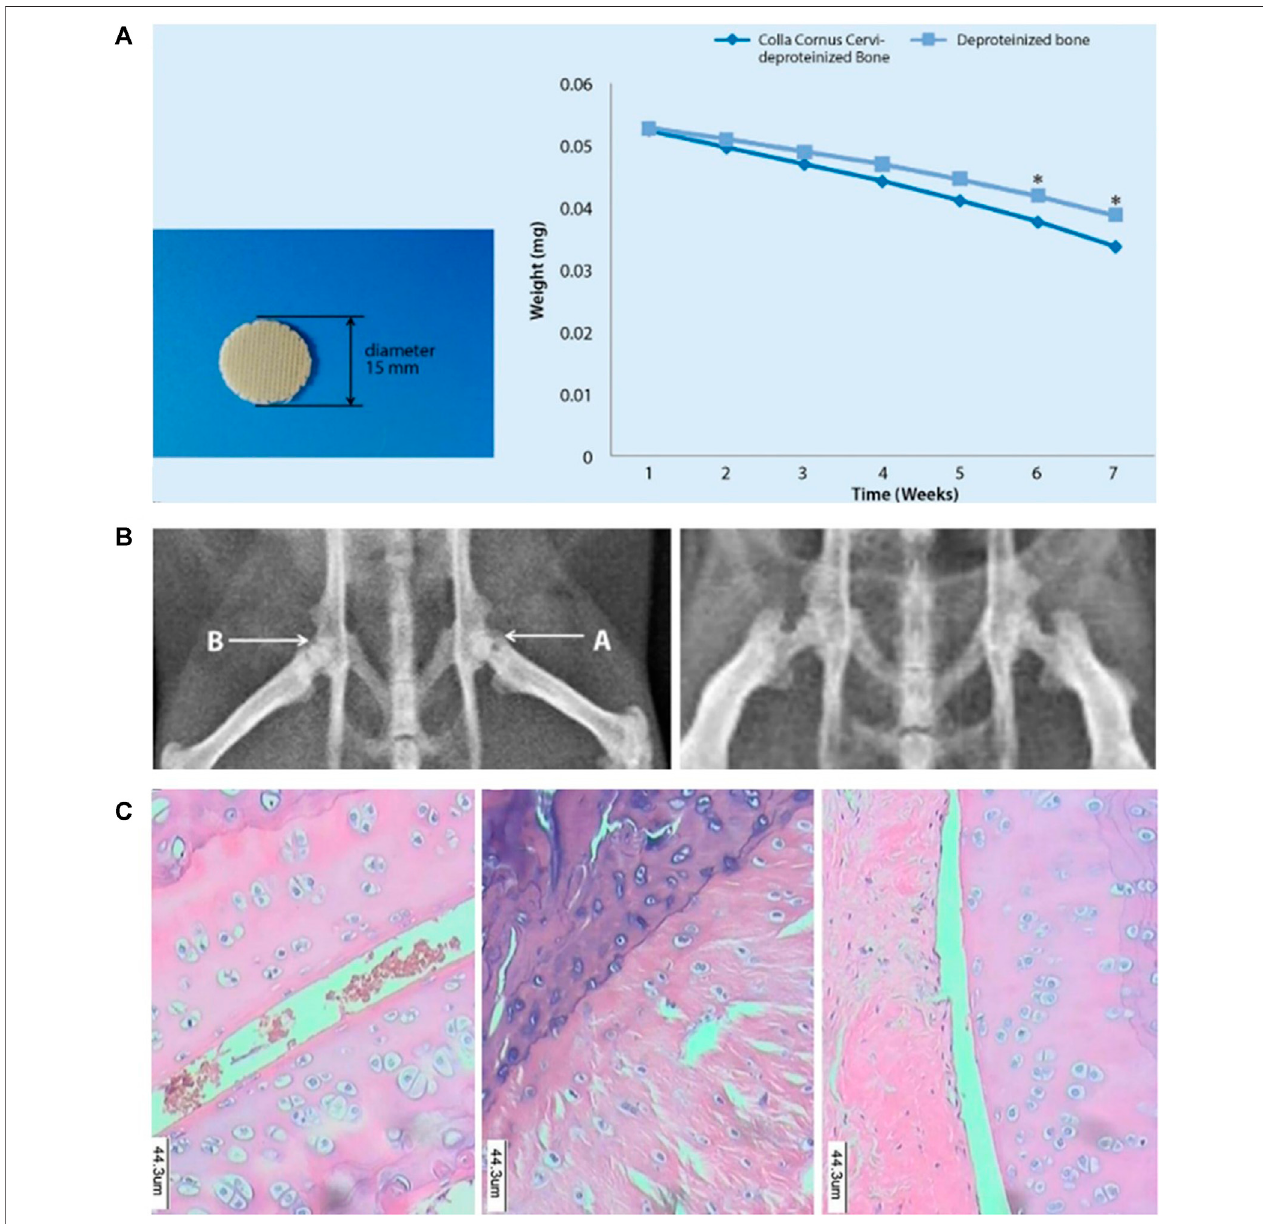
FIGURE 3 | CCC deproteinized bone scaffold reduced femoral head necrosis in rats. (A) Exterior view of a 3D printed CCC-deproteinized bone scaffold, and scaffolddegradationcurves.ThedegradationlevelsoftheCCC-deproteinizedbonescaffoldsanddeproteinizedbonescaffoldsafter6 weeksimmersioninPBSreached 35.81 and 26.61%, respectively (* p < 0.05). (B) The femoral head implanted with a CCC-deproteinized bone scaffold and the non-implanted femoral head exhibited differentoutcome. (C) Pathologicalobservationofthefemoralheadofratindifferentgroups.Signi fi cantalleviationoffemoralheadnecrosiswasobservedintherats implanted with CCC-deproteinized bone scaffolds. Reproduced with permission (Wang et al., 2019b). Copyright 2019, SPRINGER.